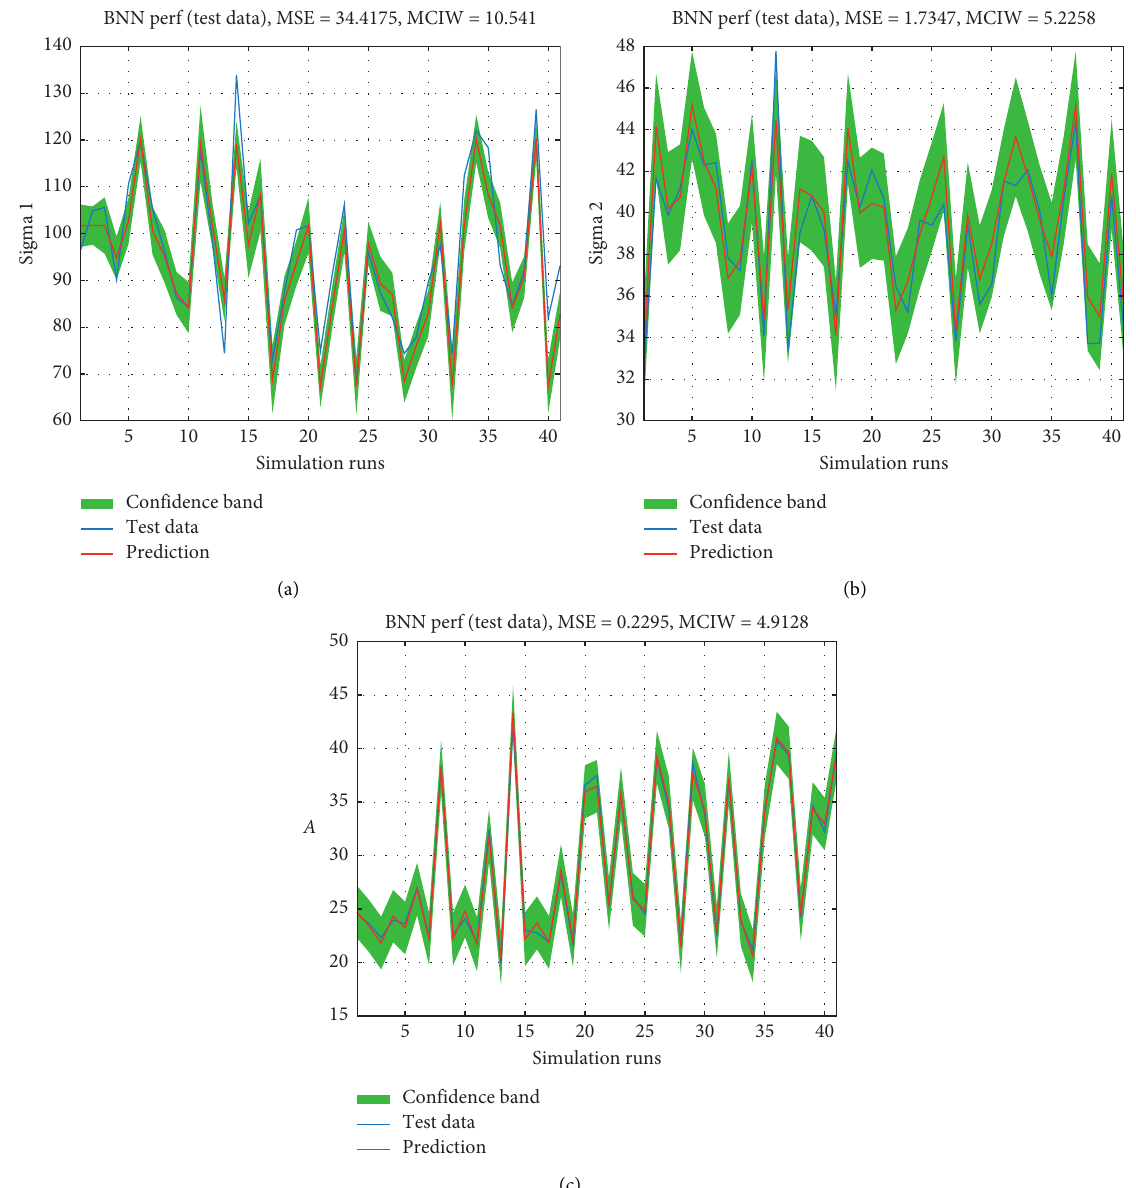
Figure 9: Performance of the trained BNN for the three output parameters σ